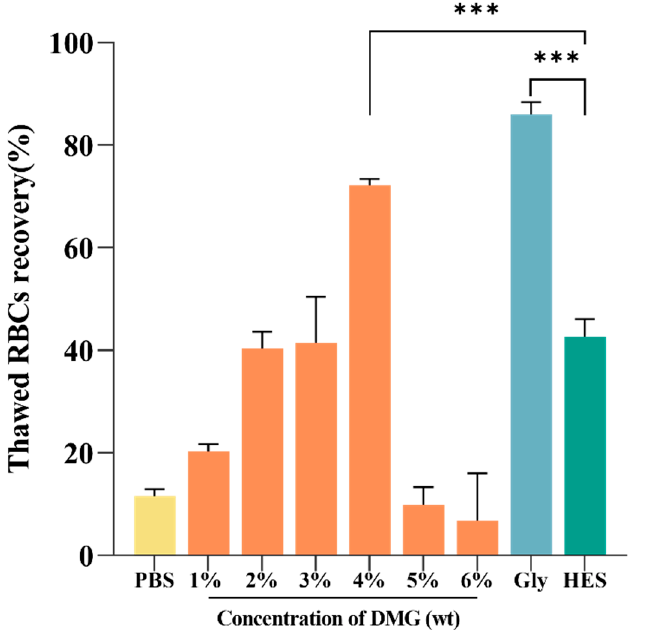
Figure 3. Thawed RBC recovery. The concentrations of Gly and HES were 20% and 13%, respectively. *** p < 0.001.